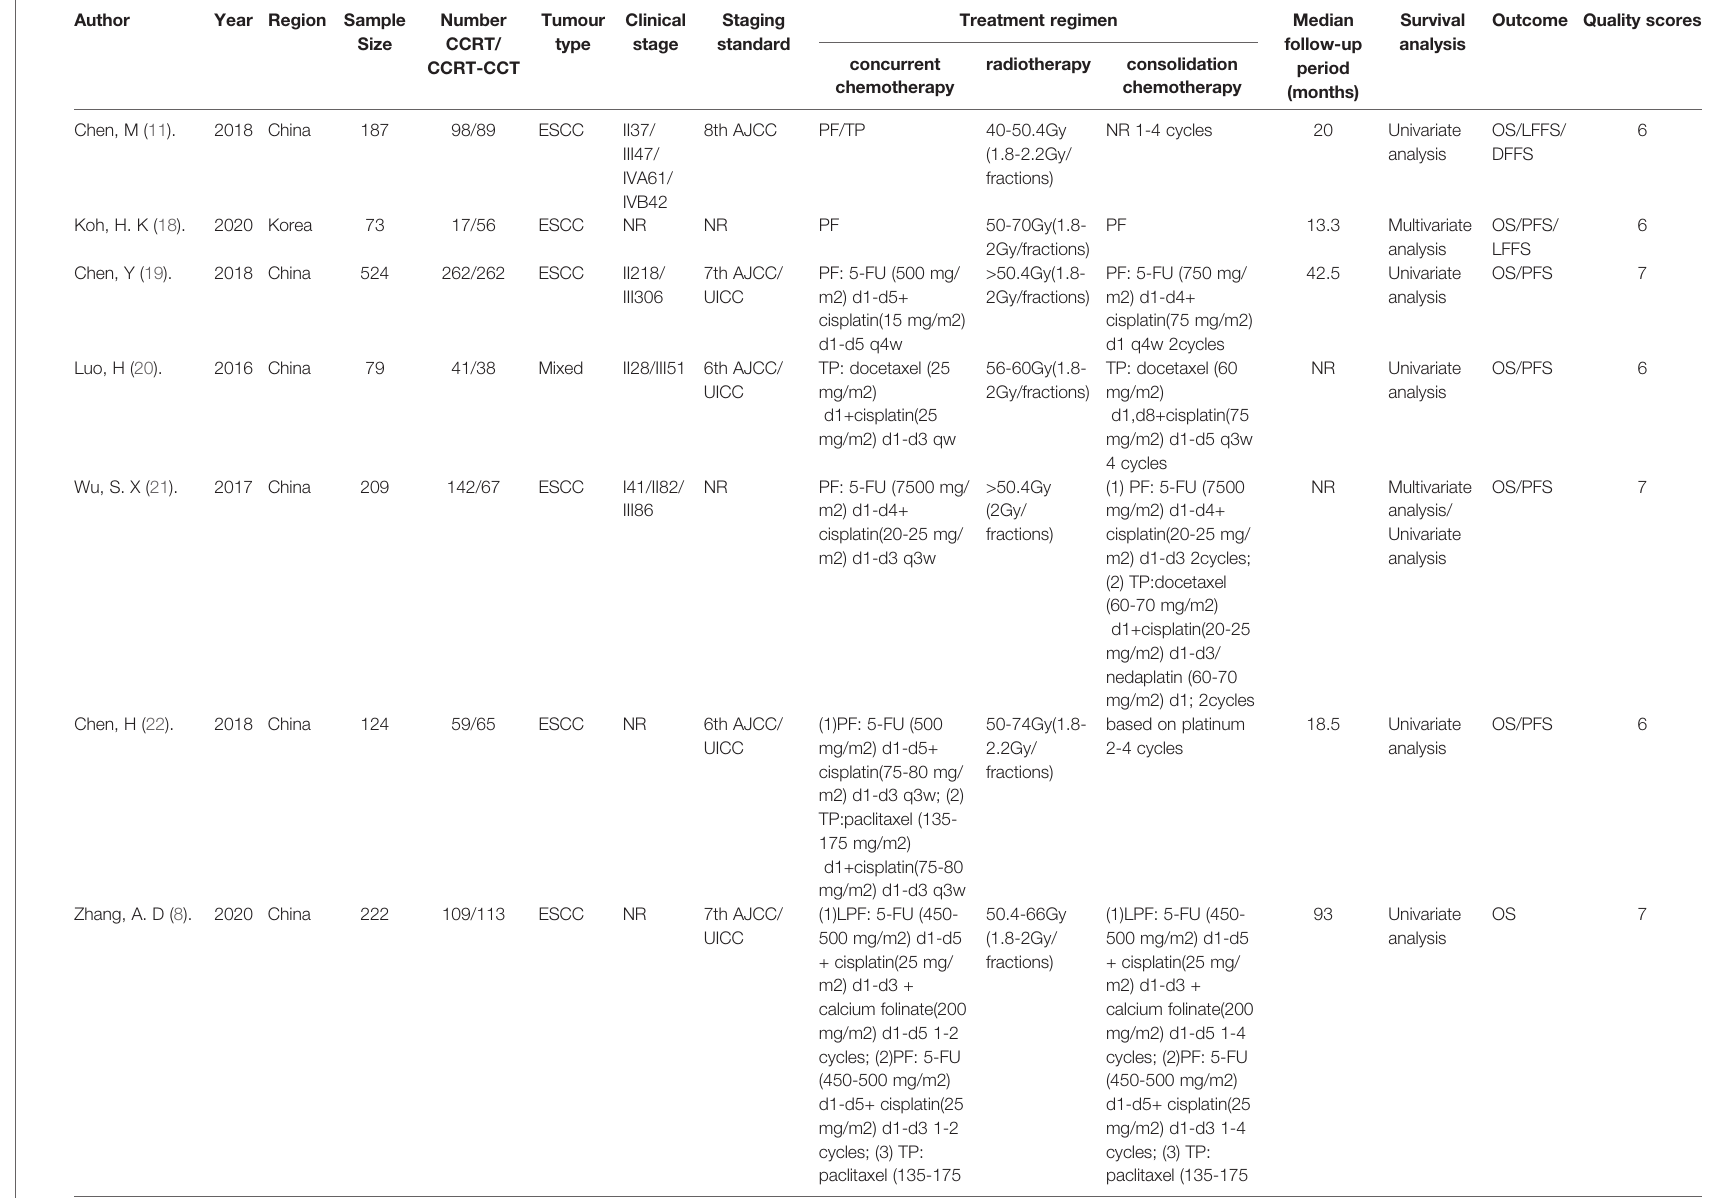
TABLE 1 | Characteristics of included